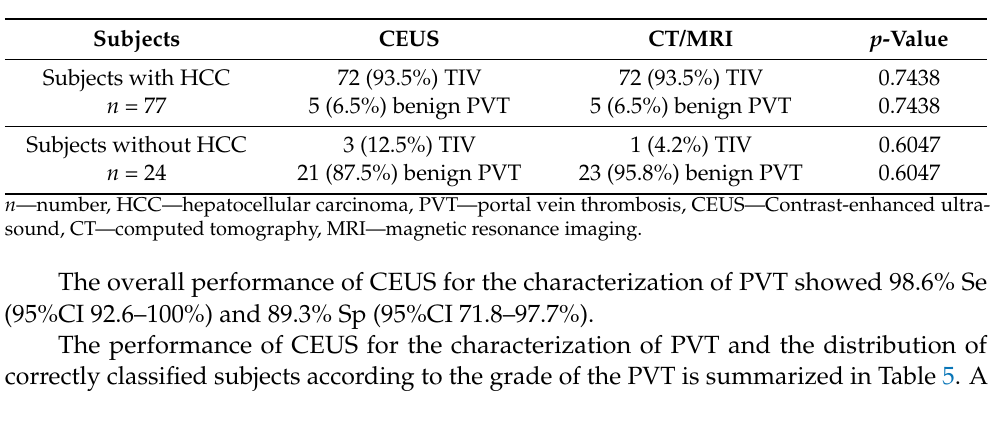
Table 4. PVT characterization, using CEUS and the gold standard